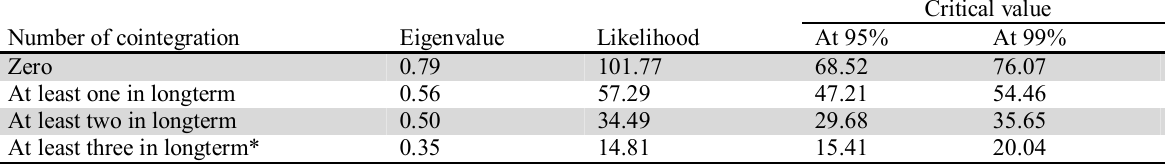
The summary of Johansen’s cointegration test for Service industry